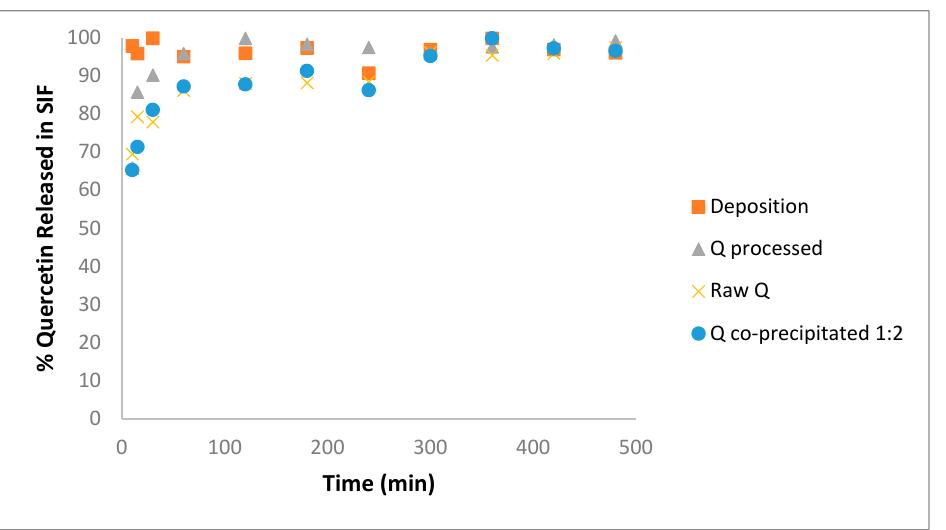
Figure 8. Release test of Q from composites in SIF corresponding to experiment 8 (180 bar, 323 K, 30 g/min CO 2 flow rate, SAS2).